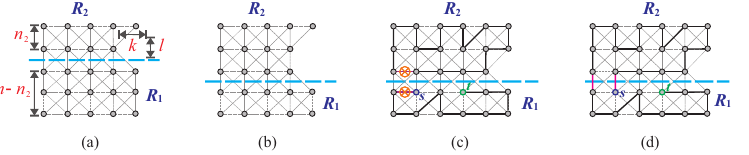
Figure 17. ( a , b ) A horizontal separation on C ( m , n ; k , l ; c , d ) under that a > 1 and d > 1, ( c ) a Hamiltonian ( s , t ) -path in R 1 and a Hamiltonian cycle in R 2 , and ( d ) a Hamiltonian ( s , t ) -path in C ( m , n ; k , l ; c , d ) for ( c